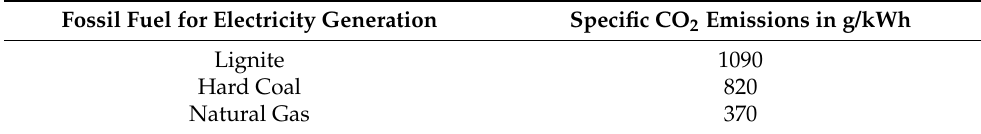
Table 1. Specific CO 2 emission for electricity generation for fossil fuels in g/kWh [27,28].